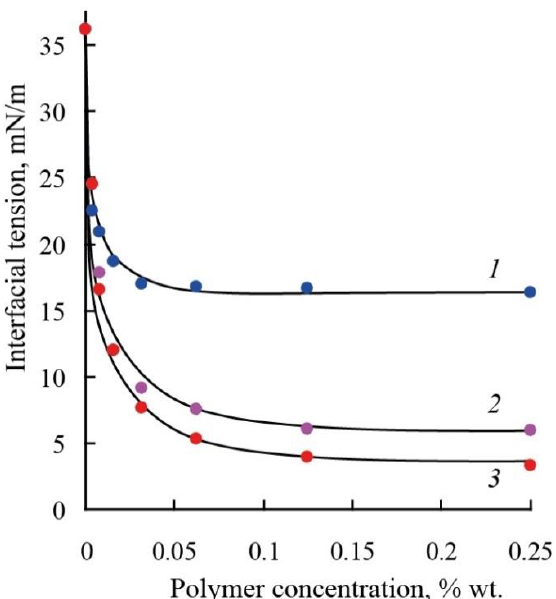
Figure 10. Interfacial tension isotherms for polymers based on macromonomers PM, PEM, and